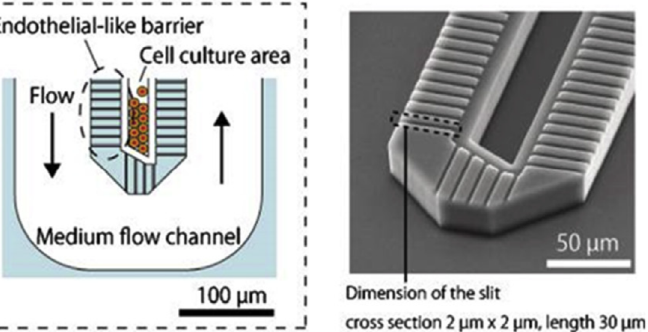
Figure 2. Liver-on-a-chip (LoC) devices have the potential to replicate the hepatic cord architec- ture [31] .